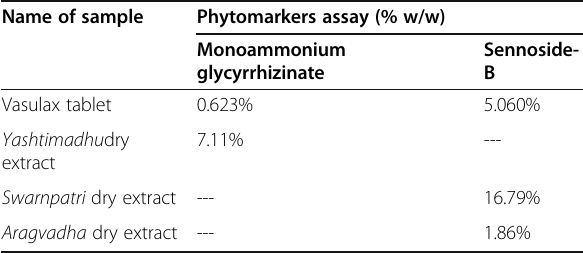
Table 3 Application of developed method on polyherbal formulation and its raw